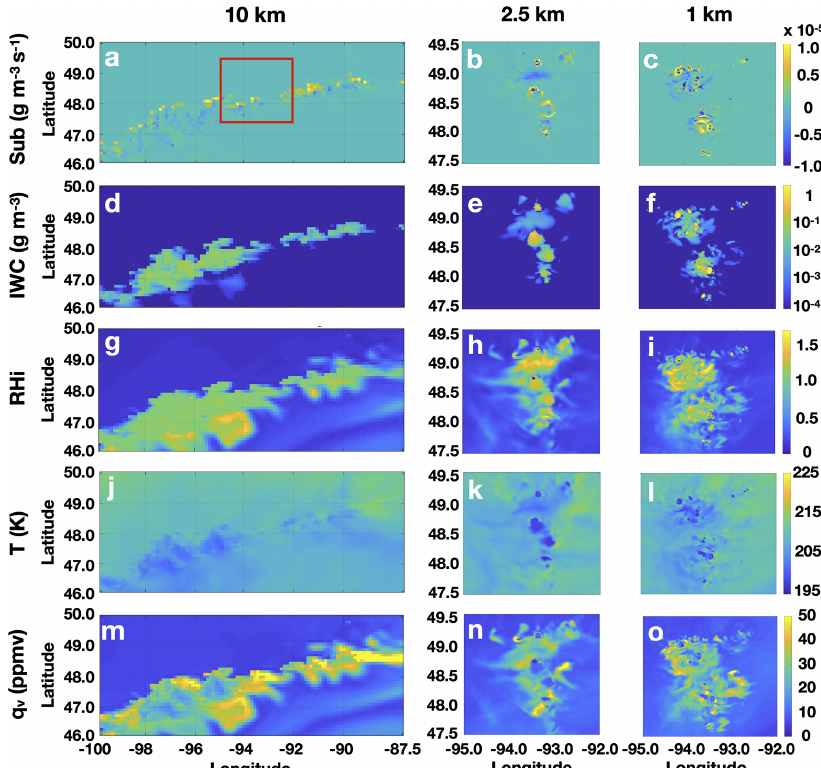
Figure 11. Distribution of a few variables in Domain A during overshooting. The results are taken from one instance, i.e., 23:25UTC, 25 August 2013, and one vertical level of ∼ 15 . 36km (above the tropopause). Shown in the three columns are the simulations at 10, 2.5 and 1km horizontal grid spacing, respectively. The area shown for the 2.5 and 1km simulations corresponds to the red rectangle in the first image. Short names for each row are used for notation: Sub, sublimation; IWC, ice water content; RH, relative humidity with regard to ice; T , temperature; and q v , water vapour volume mixing ratio.